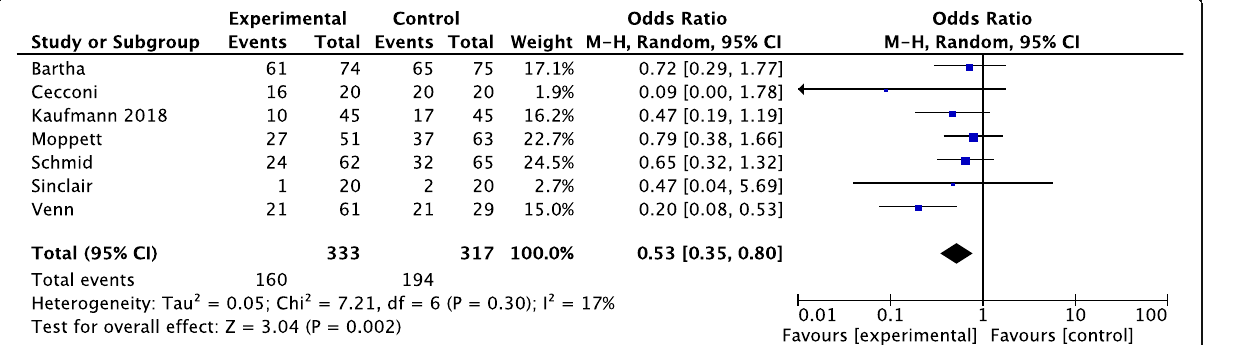
Fig. 4 Rates of postoperative complications in patients undergoing orthopedic surgery, with odds ratios (ORs) and 95% confidence intervals (CI). The pooled OR and 95% CI are shown as the total. The size of the box at the point estimate of the OR gives a visual representation of the “ weighting ” of the study. The diamonds represent the point estimate of the pooled ORs and the length of the diamonds is proportional to the CI